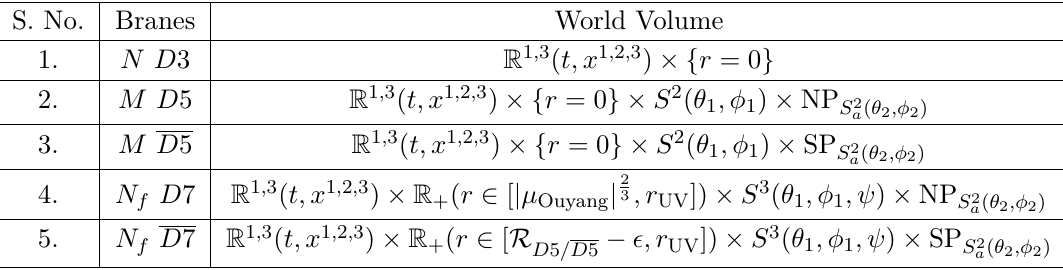
Table 1 . The type IIB Brane Construct of